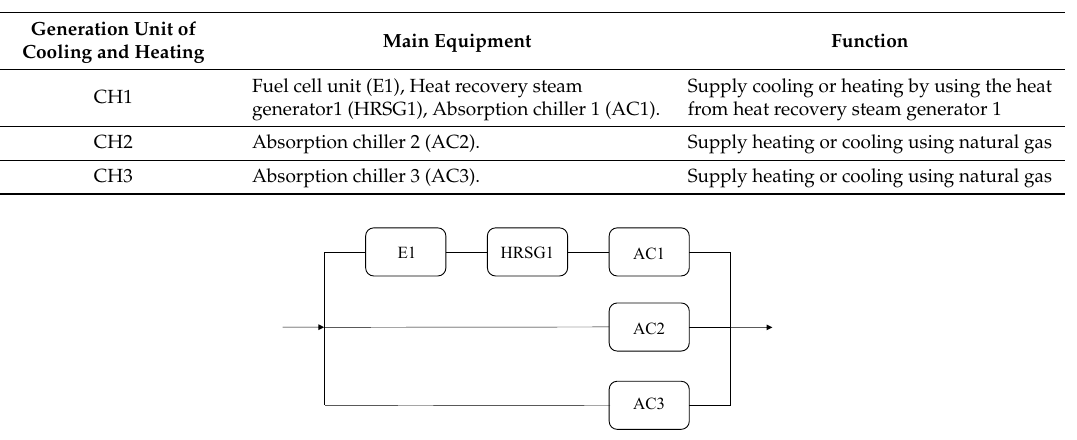
Table 7. The space cooling and heating subsystem of the CCHP system.